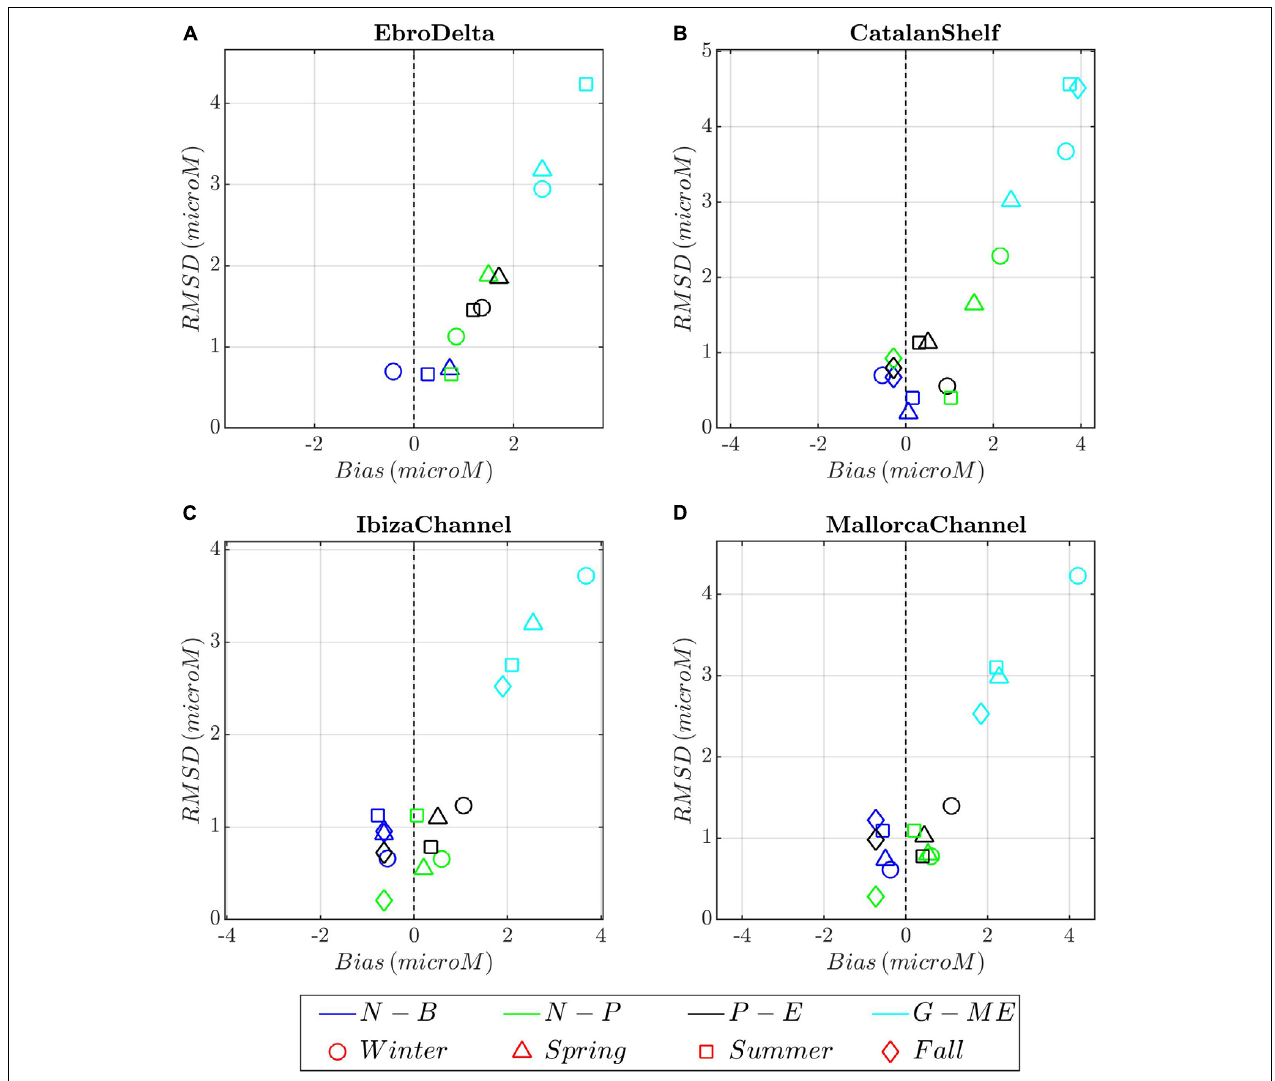
FIGURE 10 | Target diagrams between model runs (color shading) and nitrate climatological profiles for the different seasons (symbols) and areas. (A) Ebro Delta; (B) Catalan Shelf, (C) Ibiza Channel, and (D) Mallorca Channel. Model runs: blue, N-B (NEMO-BFM); green, N-P (NEMO-PISCES), dark gray; P-E (POLCOMS-ERSEM), and light blue, G-E